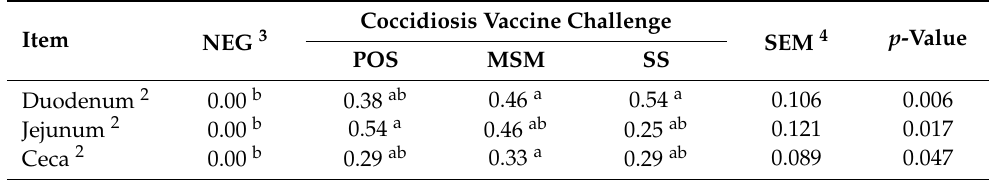
Table 7. Effect of dietary sulfur sources on gut lesion scores in coccidiosis vaccine-challenged broiler chickens 1 .